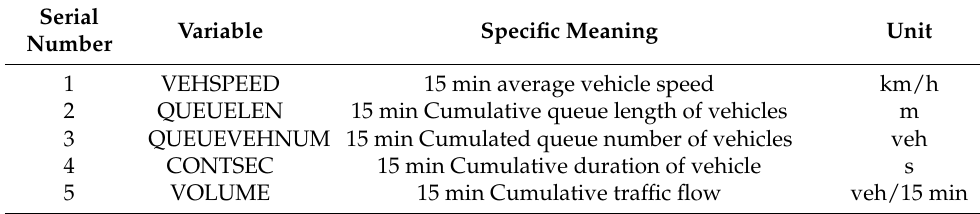
Figure 2. Random Forest algorithm schematic. Table 1. The traffic flow variables contained in the